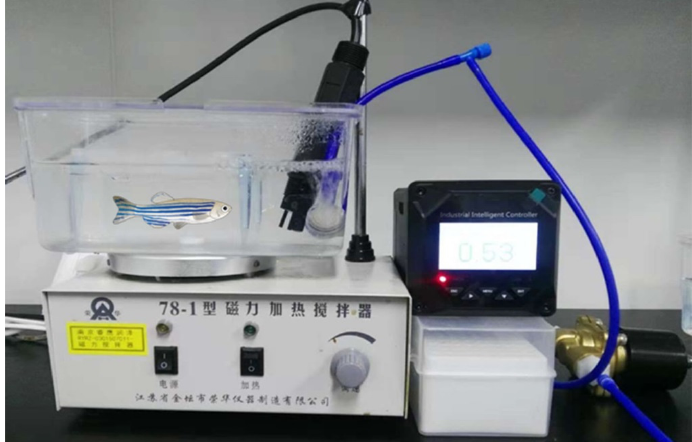
Figure 8. The experimental device of zebrafish hypoxia model.